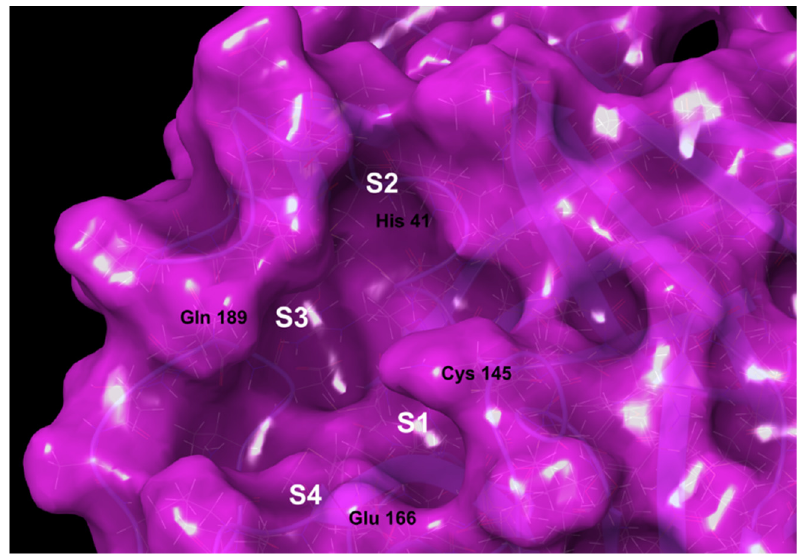
Figure 1. Focus on Mpro binding pocket (PDBid 6WCO). In white are highlighted the S1, S2, S3, S4 substrate binding pockets.